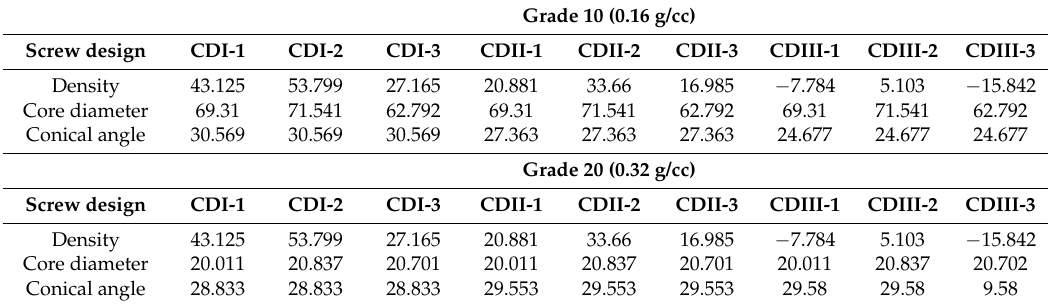
Table 3. Local sensitivity of density, core diameter, and conical angle on the artificial bone